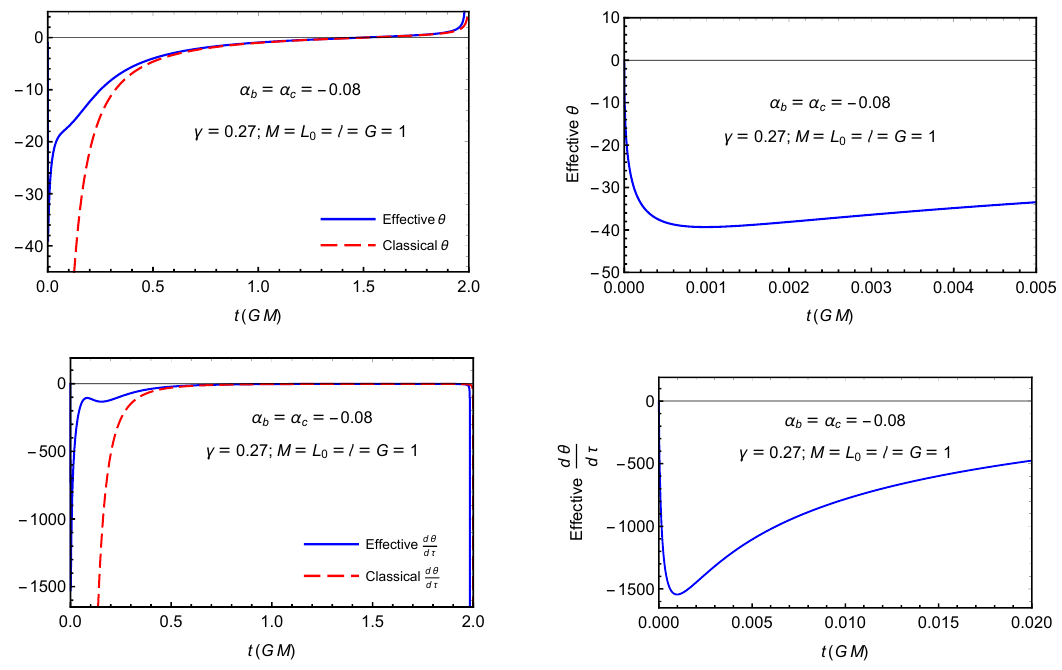
Figure 6 . Plots of expansion and its rate of change for model 3. Top left: classical vs effective θ as a function of the Schwarzschild time t . Top right: closeup of the effective θ as a function of t . Bottom left: classical vs effective dθ as a function of t . Top right: closeup of the effective dθ dτ function of t